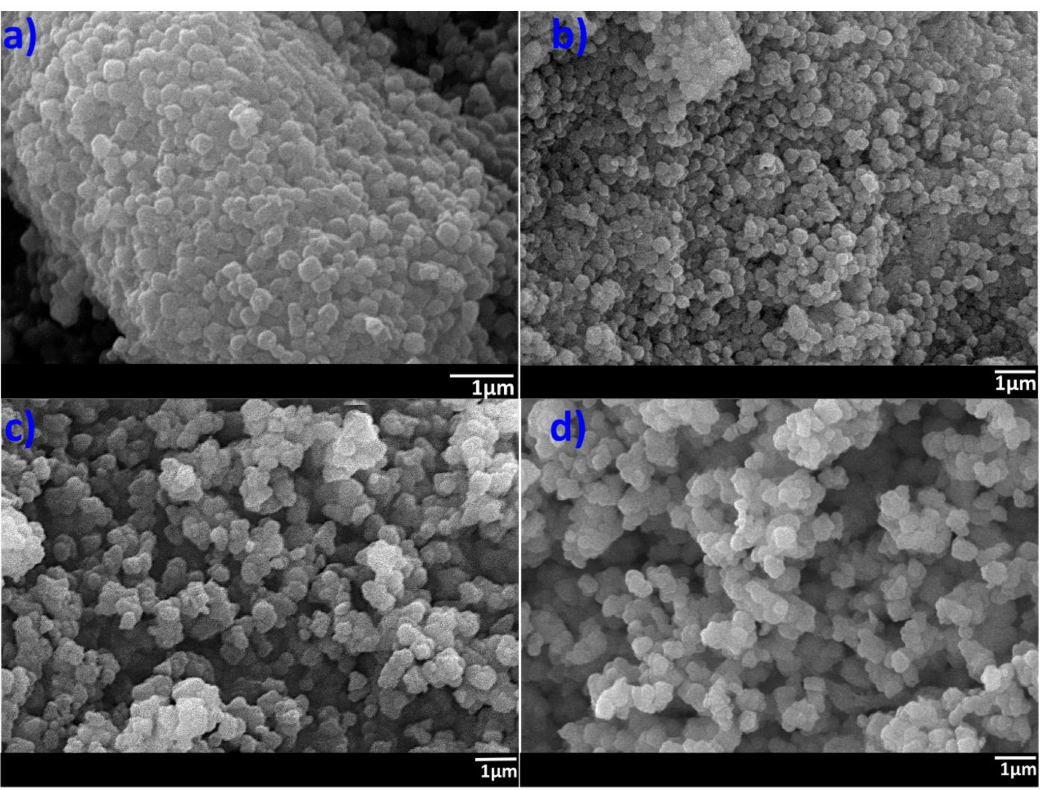
Figure 7. SEM images of ( a ) MOR-1 , ( b ) MOR-2 , ( c ) MOR-1@DCF − , and ( d ) MOR-2@DCF − .